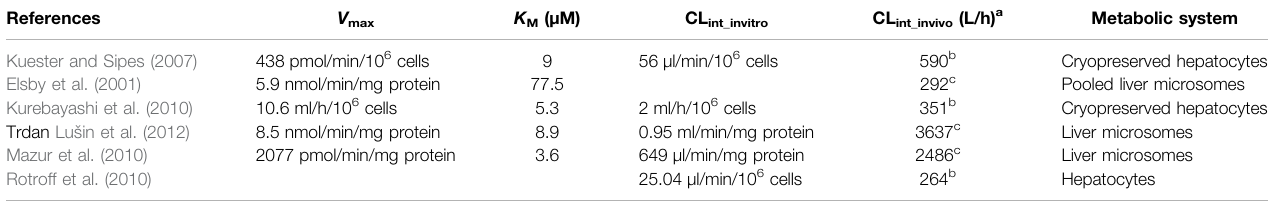
TABLE 1 | Metabolism kinetics of BPA found in the literature.